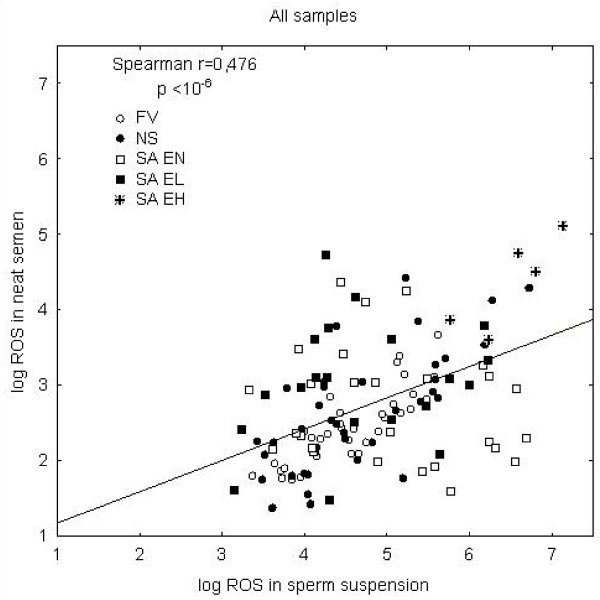
Correlation between log10 ROS in neat semen and log10 ROS in sperm suspension in PBS in all samples. Individual groups are differentiated by symbols.